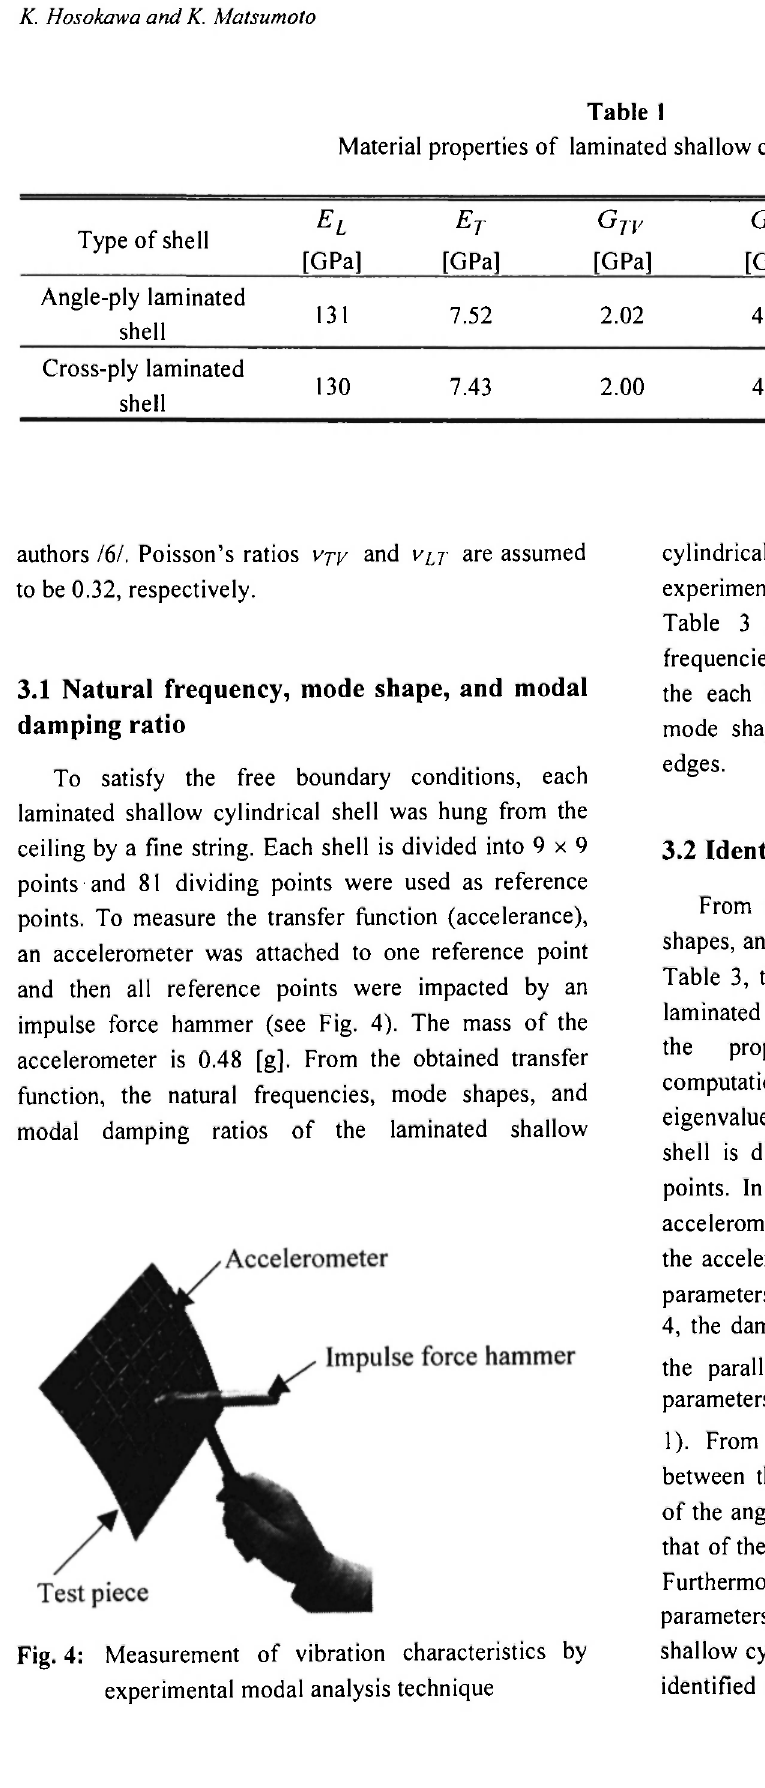
Fig. 4: Measurement of vibration characteristics by experimental modal analysis